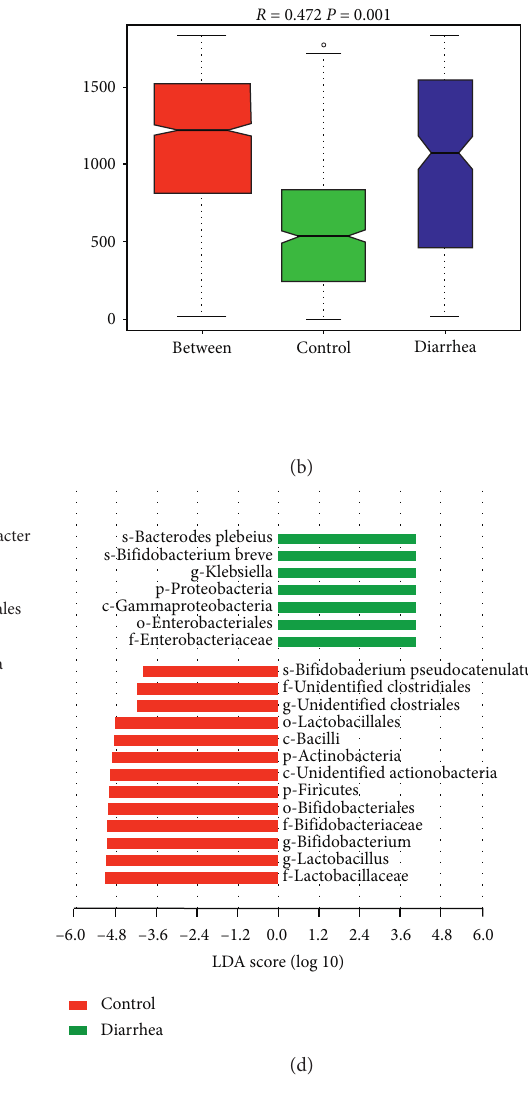
Figure 3: The beta diversity and predominant microbiota of healthy and diarrheic infants. (a) The nonmetric multidimensional scaling (NMDS) of beta diversity is calculated on ranking order. (b) The ANOSIM Similarity Analysis is based on a nonparametric test to compare intragroup and intergroup differences. (c) Cladogram indicating the phylogenetic distribution of microorganisms as related to group characteristics; the difference was shown in red for the healthy group and green for the diarrhea group. The diameter of each circle was proportional to the taxa’s abundance. The strategy of multiclass analysis was not strict (at least one somewhat differential). The circle from inside to outside represented the phylogenetic level from domain to genus. (d) Indicator microbial groups within the two types of sediments with a linear discriminate analysis (LDA) value greater than 4.0. The color lump represented the microbes with a significant difference at different taxonomic levels. Red and green represented the healthy group and the diarrhea group, respectively. The x -axis represented the LDA score of the microbes. The y -axis represented the microbes, which were detected to be significantly different in the